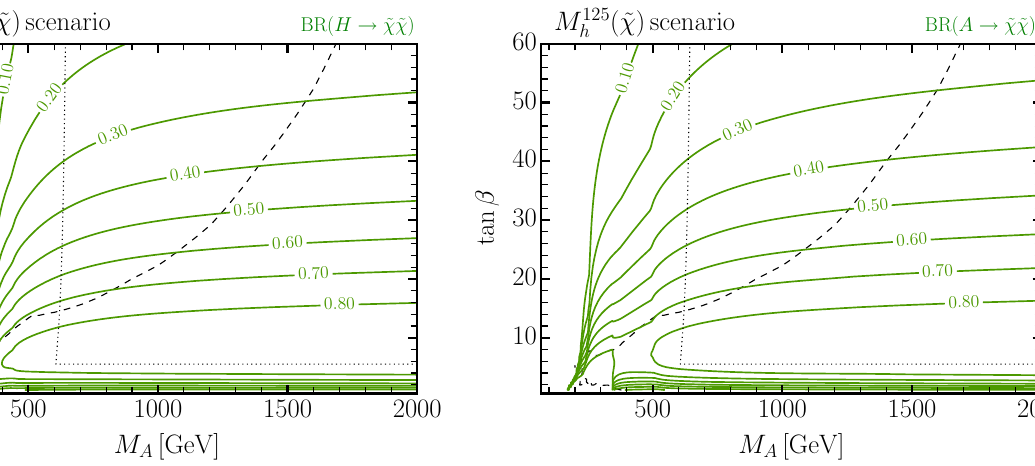
Fig. 7 Branching ratio for the decays of the heavier CP -even scalar H each plot, the boundaries of the blue and the hatched exclusion regions (left) or the CP -odd scalar A (right) into EW-ino pairs, as a function of Fig.5 are also shown as a dashed and a dotted black line, respectively ( ˜ χ) scenario. A sum is taken over all the of M A and tan β in the M 125 h kinematically allowed combinations of particles in the final state. In